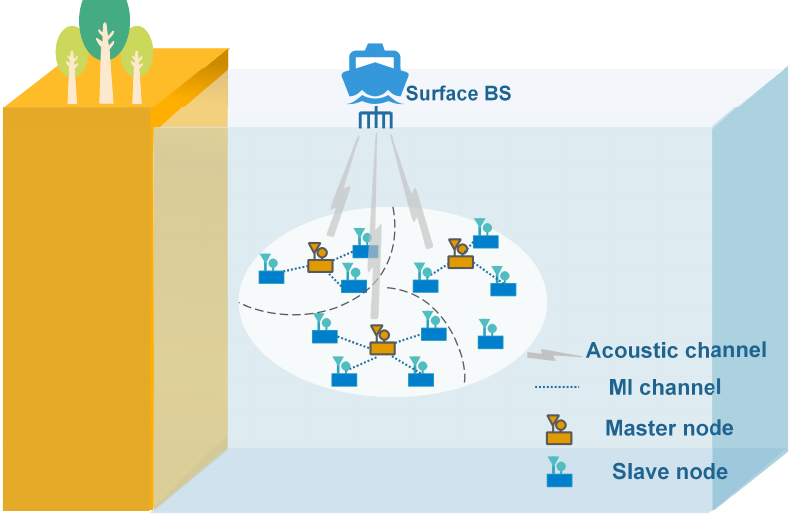
Figure 1. The system overview of the underwater MI-assisted acoustic cooperative MIMO